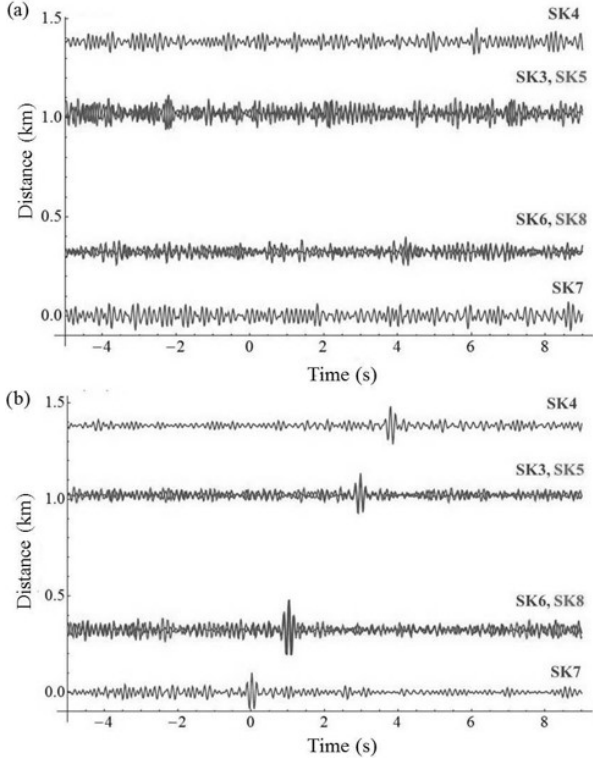
Figure 10. Empirical Green’s functions calculated from records of small-aperture arrays in the Kuusamo experiment in the frequency band of 5–10Hz and stacked (vertical components): (a) by the sim- ple stacking method; (b) by the SNR-stacking method. The EGFs in panels (a) and (b) are sorted according to distance from sensor